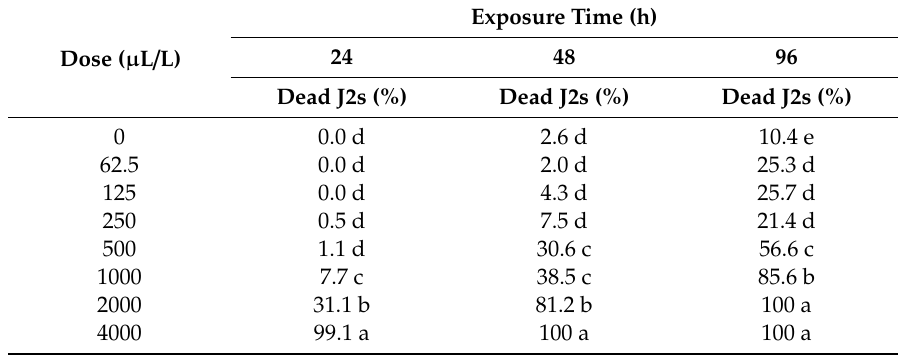
Table 2. E ff ect of essential oil on the motility of M. incgonita second stage juveniles (J2s) after